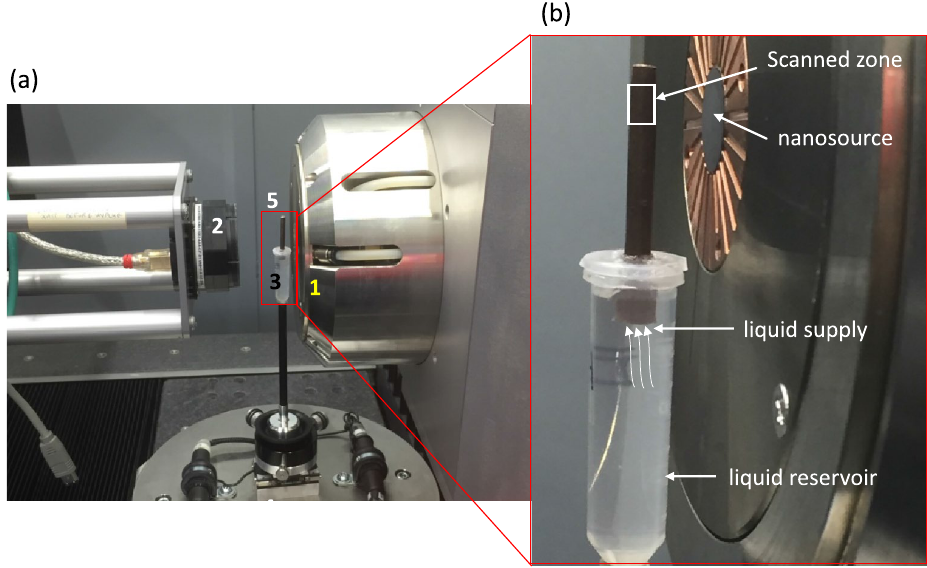
Figure 2. Laboratory-scale tomography used to study the mechanism of liquid transport in wood: ( a ) experimental setup, 1-X-ray nano-source with a tungsten filament, 2-CCD detector, 3-liquid provider, 4-rotation axis, and 5-wood specimen; and ( b ) scan area of the wood specimen in the case of silicone oil imbibition facing the nano-source (photographs by M.